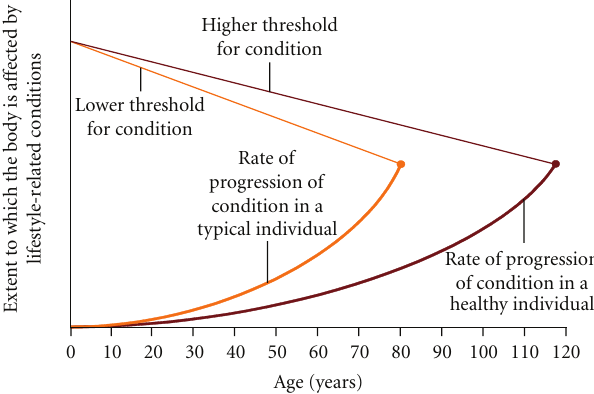
Figure 1: Theoretical relationship between the threshold of lifestyle-related conditions and their rate of progression over the life cycle. Horizontal axis: age. Vertical axis: extent to which the body is a ff ected by lifestyle-related conditions. Top light line: threshold for chronic conditions with average Western lifestyle. Lower light line: rate of progression of chronic conditions with average Western lifestyle. Top dark line: threshold for chronic conditions with a healthy lifestyle. Lower dark line: rate of progression of chronic conditions with a healthy